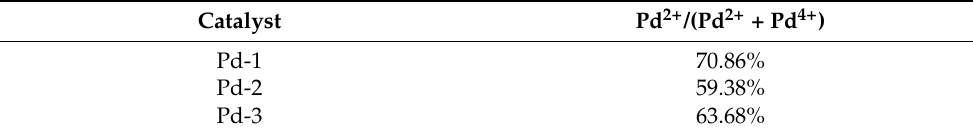
Figure 7. XPS results of Pd 3d in Pd-1, Pd-2 and Pd-3. Table 5. Proportion of Pd 2+ species to total Pd species in catalysts Pd-1, Pd-2 and Pd-3.